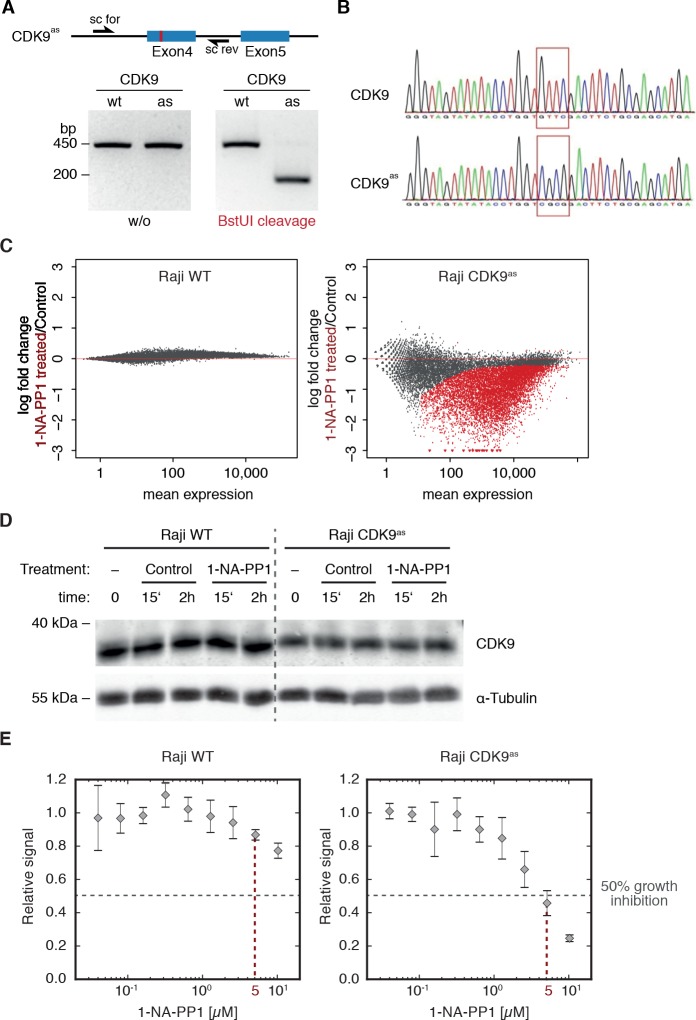
CRISPR-Cas9 directed engineering, cellular and biochemical characterization of CDK9as Raji B cell line.(A) BstUI restriction enzyme recognition site used for screening is indicated in the HDR template sequence (highlighted in red). Agarose gels of screening PCRs followed by restriction digest with BstUI of wild type (wt) and CDK9as (as) Raji B cell line. (B) Validation of CDK9as Raji B cell line by sequencing. (C) Log fold change upon 1-NA-PP1 treatment (5 µM for 15 min) versus the normalized mean read count across replicates and conditions for wild type Raji B cells (left panel) and CDK9as Raji B cells (right panel). Significantly up- or downregulated TUs (adjusted p-value<0.01) are marked in red. (D) Wild type and CDK9as Raji B cells were treated with 10 µM of 1-NA-PP1 for 15 min or 2 hr. DMSO was used as control. Stable CDK9 protein levels were detected by Western blotting (Materials and methods). α-Tubulin was used as loading control. (E) Cell proliferation at increasing 1-NA-PP1 inhibitor concentrations (log scale) was determined using a colorimetric assay based on MTS metabolization (Materials and methods). Cell proliferation of CDK9as Raji B cells was dramatically reduced by >50% when 1-NA-PP1 concentrations of 5 µM (indicated with dashed red line) or higher were used, whereas wild type Raji B cells were largely unaffected. Error bars indicate the standard deviation (n = 4).